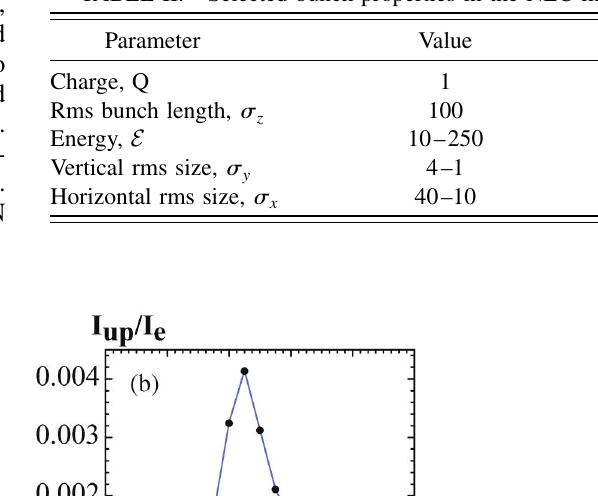
TABLE II. Selected bunch properties in the NLC linac.